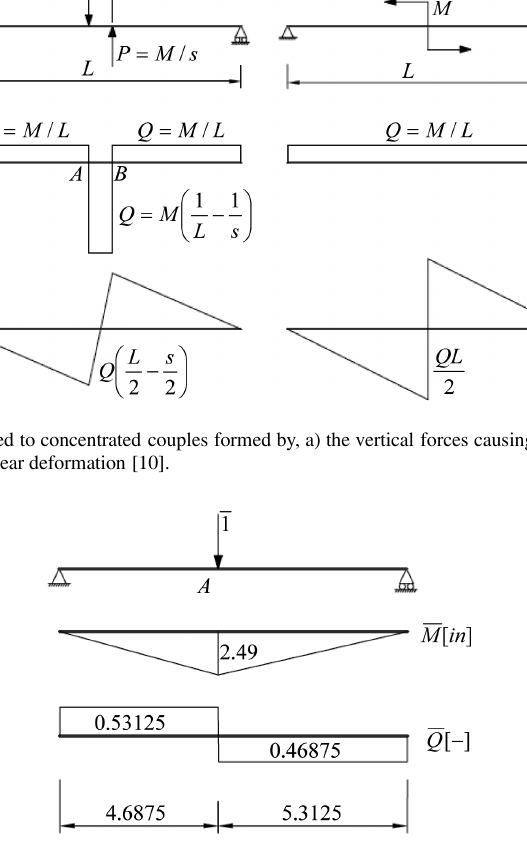
Fig. 5. Simply supported beam subjected to a virtual displacement unit force at point A , virtual bending moment ¯ M , and shear force ¯ Q diagram. The vertical displacement at point A , due to bending moment and shear force, is expressed